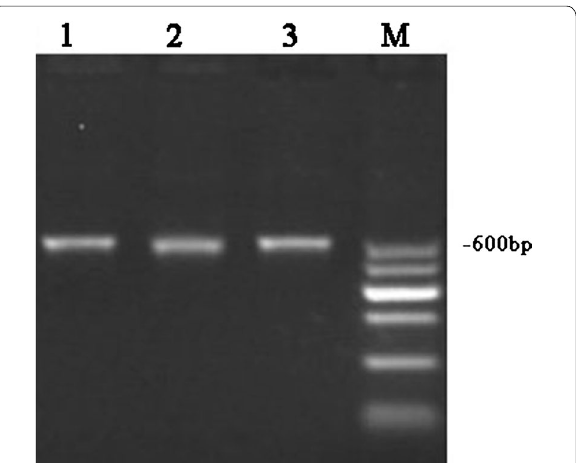
Fig. 4 PCR products of the amplification of the V3-V4 variable region of the 16S rDNA using the DNA extracted with the CLU, ZBC and QIA methods as templates. Lanes: M molecular marker. 1, CLU method; 2, ZBC method; and 3, QIA